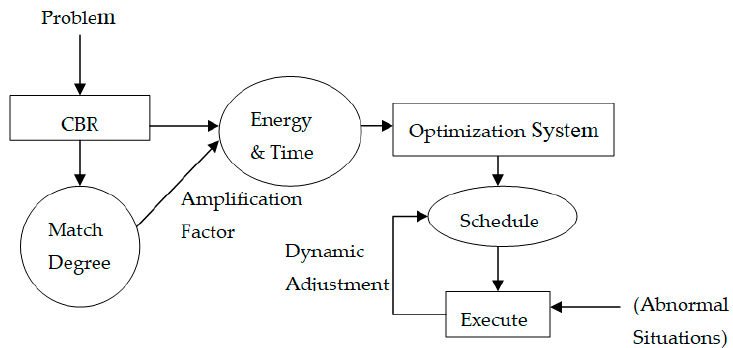
Figure 1. Vehicle management system architecture.